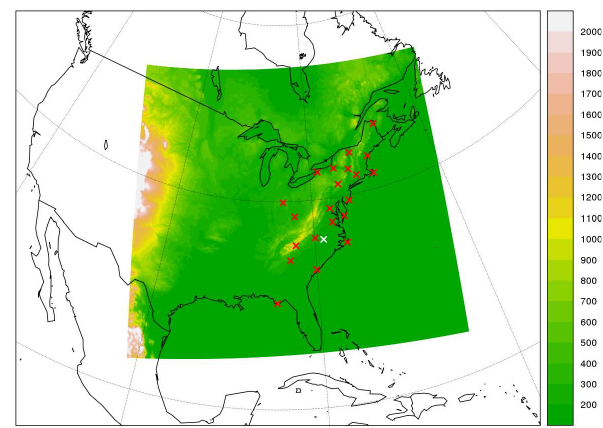
Fig. 1. COSMO iso model domain and topography (colours, in me- tres a.s.l.). Red crosses show the locations of measurement stations where δ 18 O in precipitation was analysed by GL90. The white cross denotes the location of the station RDU where vapour isotopes were